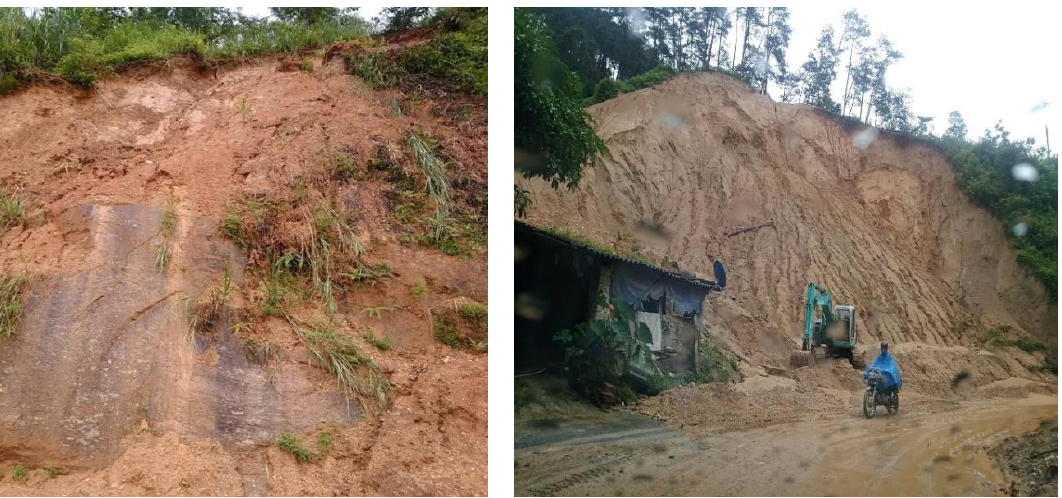
Figure 2. Photo of two recent landslides at the Lang Son area (the photos were taken on October 2016 by Ha Viet Pham).